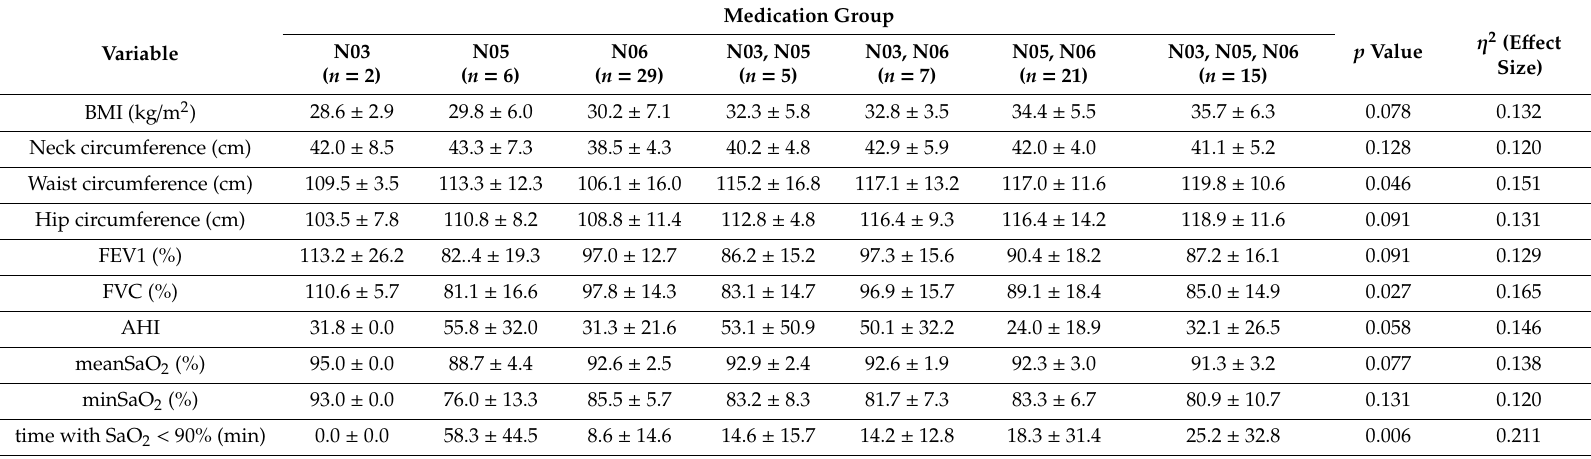
Table 4. Impact of psychotropic medications on BMI, neck, waist, and hip circumferences, FEV1 (%), FVC (%), AHI, meanSaO 2 (%), minSaO 2 (%), and time spend with SaO 2 < 90% during